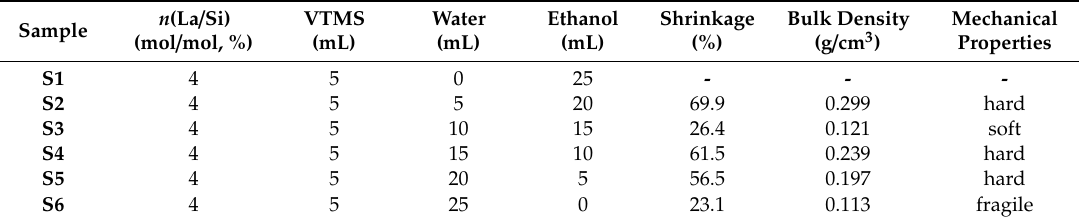
Table 1. Physical Properties of Samples with Di ff erent Solvent Proportions. Uncertainties Refer to the Confidence Interval at